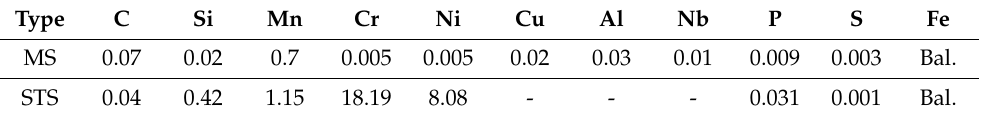
Table 1. Chemical composition (wt%) of mild steel (MS) and 304 stainless steel (STS).